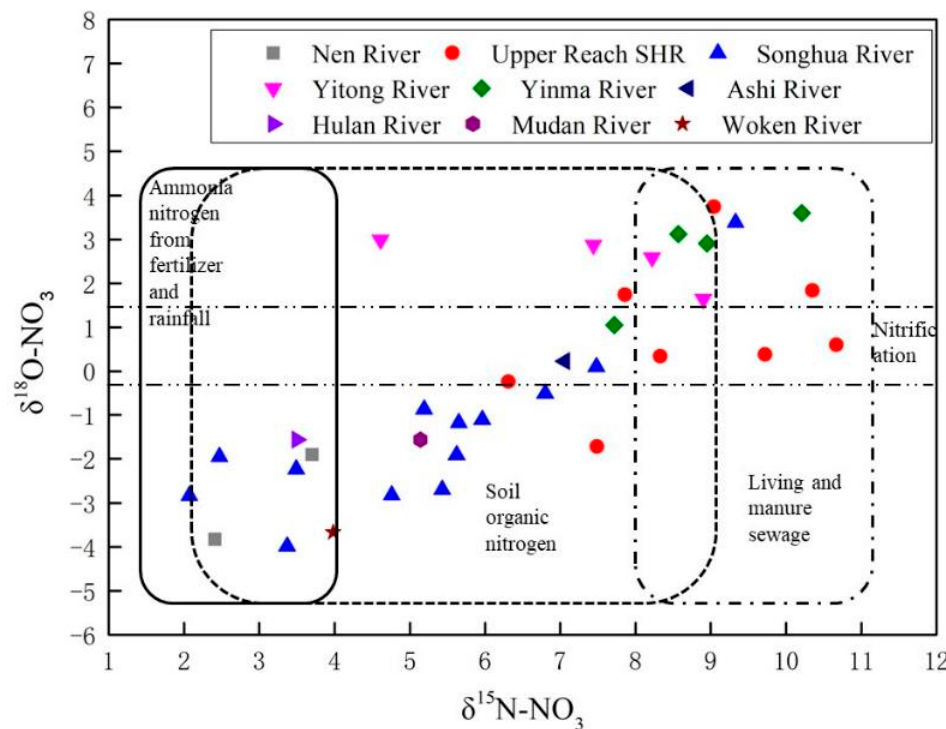
Figure 4. The relationship between δ 15 N and δ 18 O values of nitrate in the SHR during high flow season.